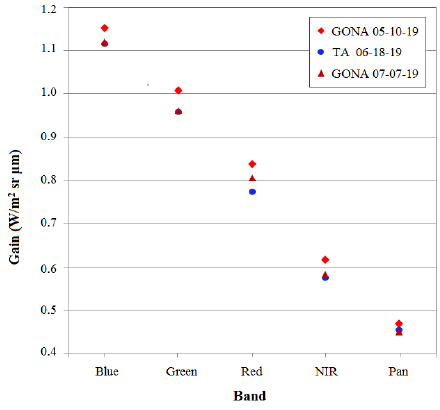
Figure 8. Comparison of the results obtained from the data collected in the Atacama v/s the outputs using GONA RadCalNet station data.